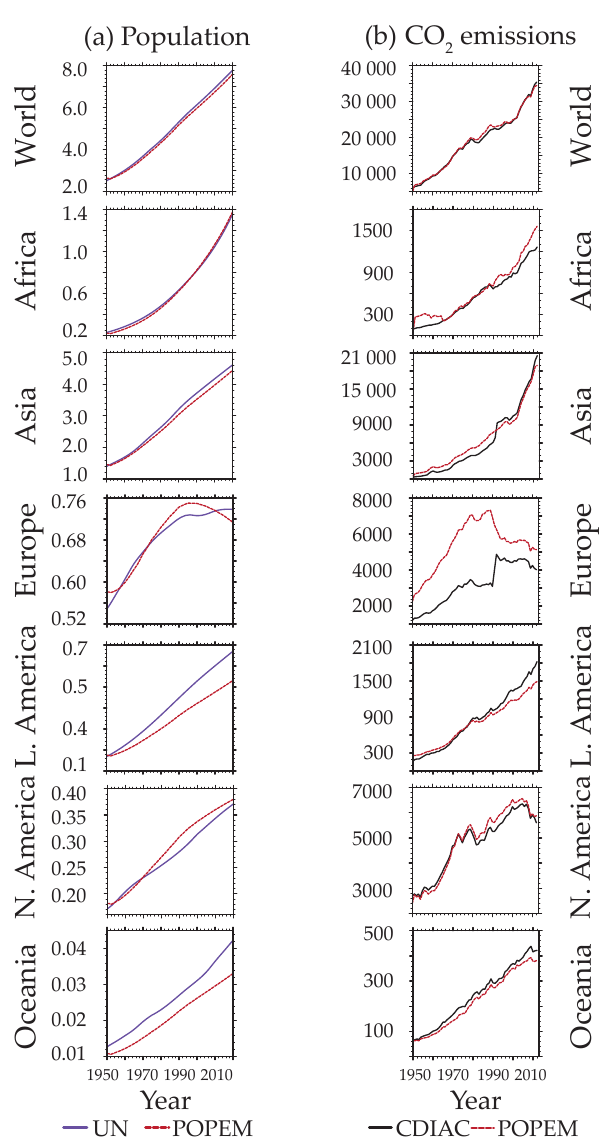
Figure 2. Comparison of the population estimates for the years 1950–2020 (a) and the historical CO 2 emission estimates for the years 1950–2012 (b) . The first row compares global data, the second to seventh rows compare regional data (Africa, Europe, Latin America, North America, and Oceania). In (a) , the red line shows the estimates given using POPEM and blue indicates UN es- timates. Values are given in billions of people. In (b) , the red line shows the estimates given using POPEM and the black indicates CDIAC estimates. Units are given in million metric